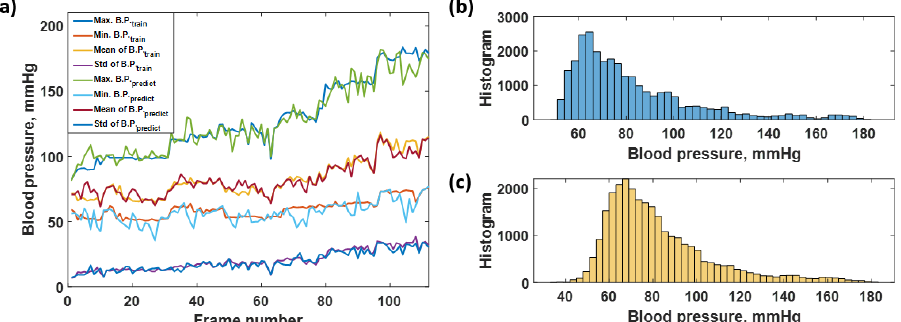
Figure 11. Shows the ( a ) average max, min, mean, and standard deviation of each frame number for the test dataset and predicted responses; ( b ) histogram of blood pressure level covering in the actual testing blood pressure data; and ( c ) histogram of blood pressure level covering in the predicted blood pressure data.